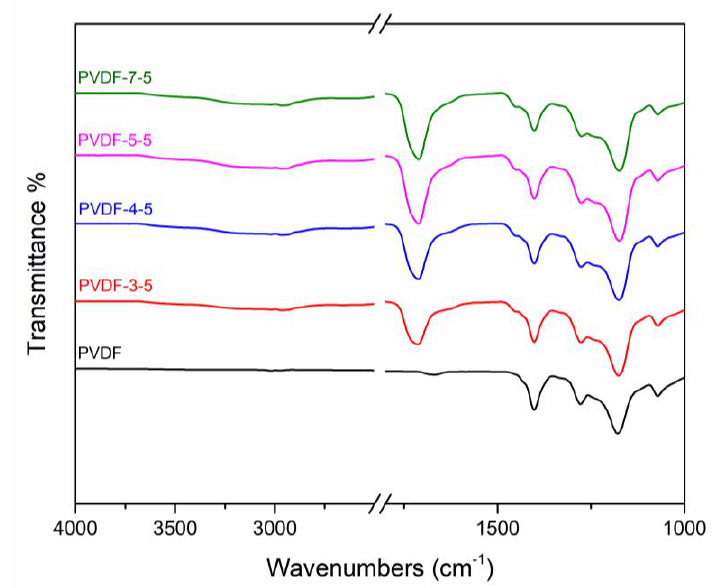
Figure 1. ATR–FTIR spectrum of unmodified membrane (PVDF) and modified membranes (PVDF-3-5, PVDF-4-5, PVDF-5-5, PVDF-7-5). The acrylic acid (AA) monomer concentration was 5 w / v %, and the benzophenone (BP) photoinitiator concentration was kept at 2 w / v %. Table 1. Elemental composition of the membrane surface from XPS analysis.